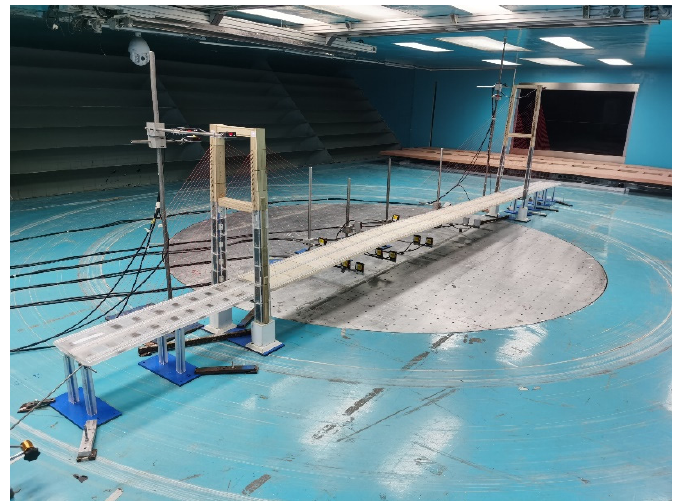
Figure 13. Full bridge aeroelastic model in TJ-3 wind tunnel.